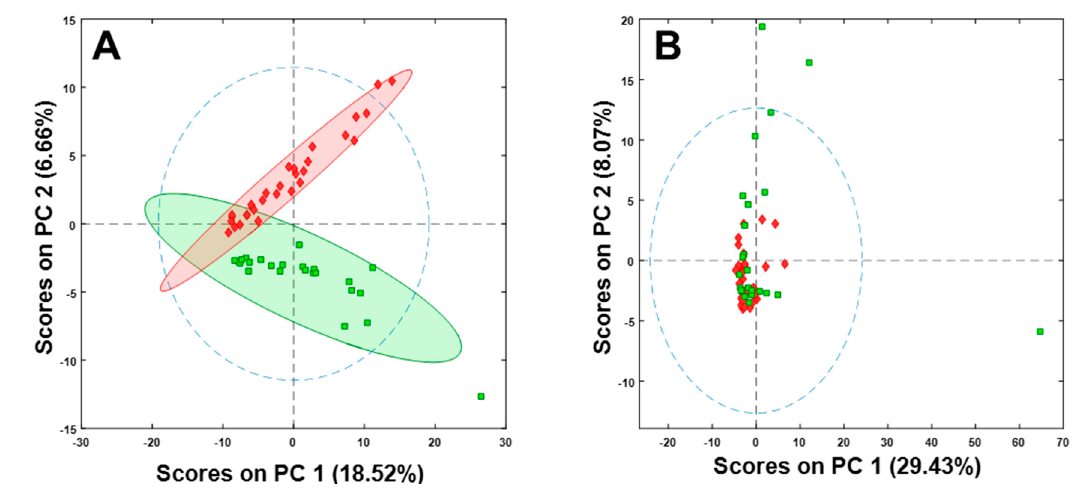
Figure 3. PCA score plots with 306 variables that were selected for TUPA modelled on the dataset ( A ) without normalization ( B ) normalization to